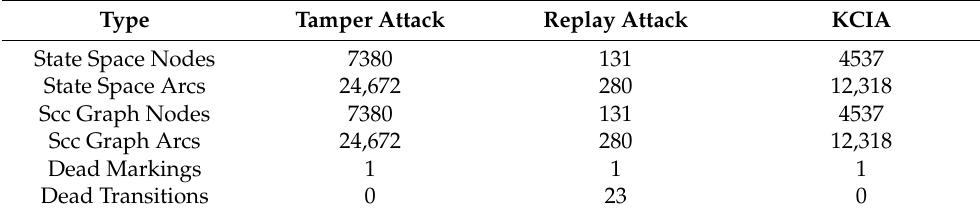
Table 5. State space analysis of the model.